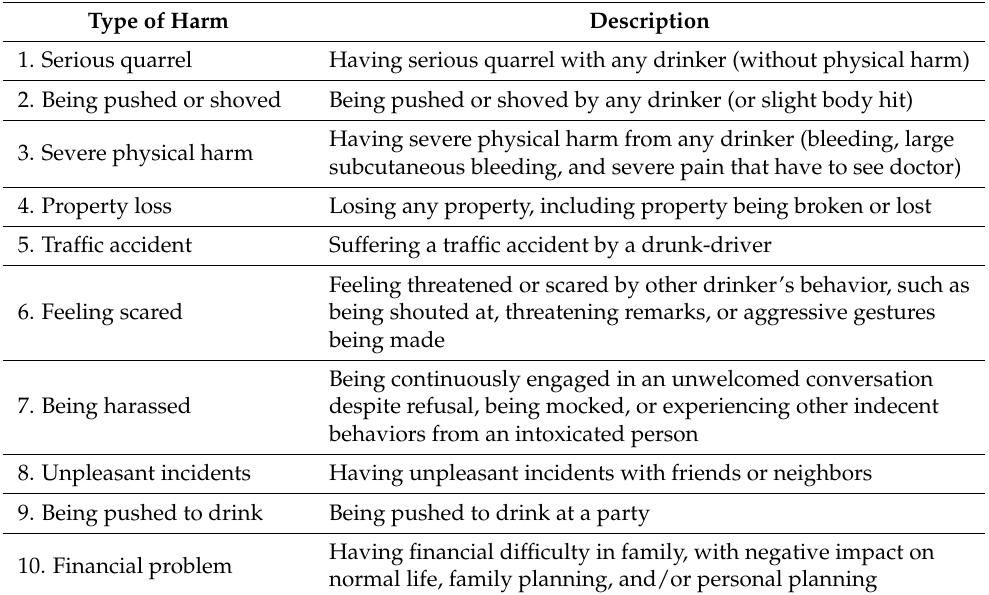
Table 1. Type of harms occurring to the participants from other’s